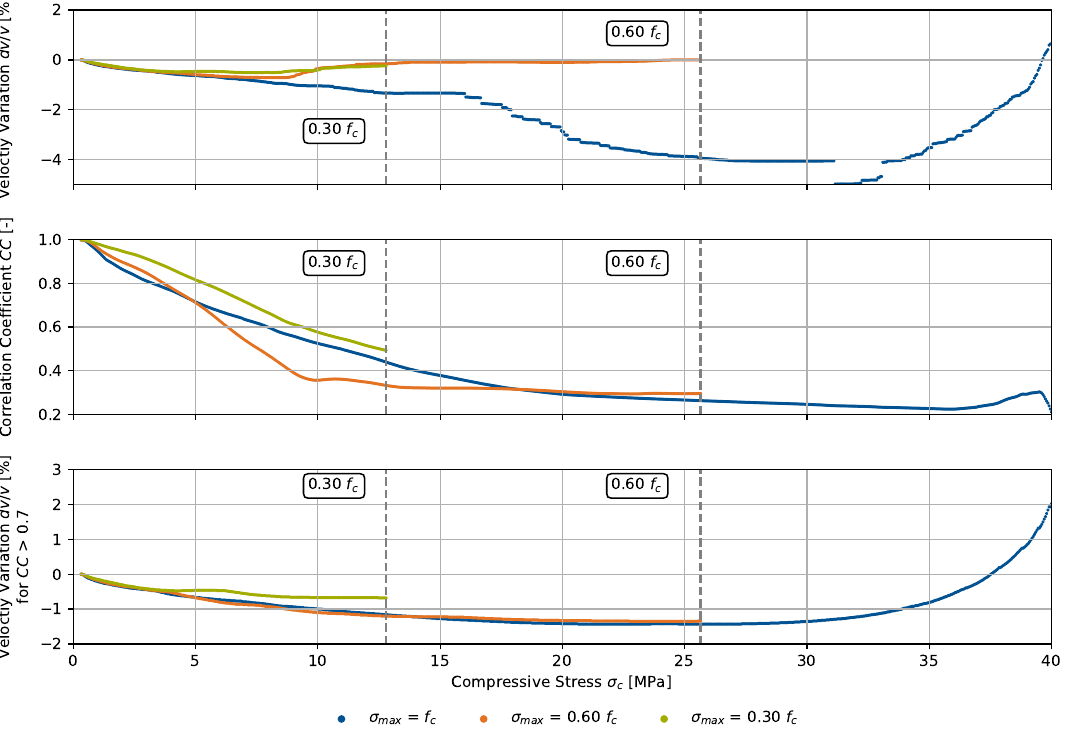
Figure 8. Velocity variation dv / v and signal correlation coefficient CC for three specimens as in Figure 7, translated into the compressive stress domain during the loading process up to 100% (failure), 60%, and 30% of the compressive strength f c